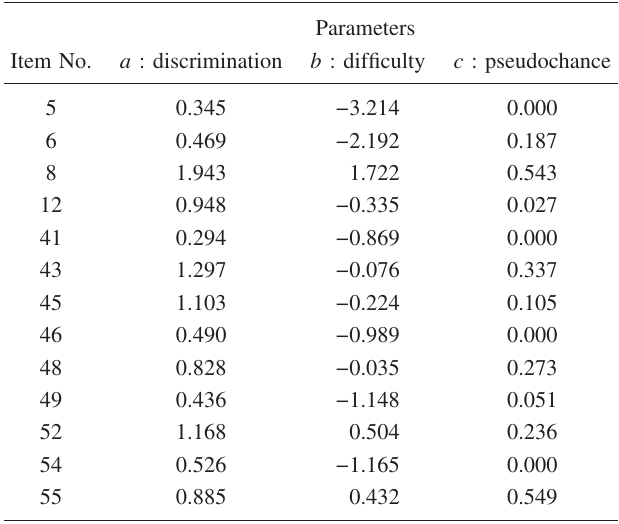
TABLE VIII. Numbers of physics and physical science items with each answer classification code by year and grade level.